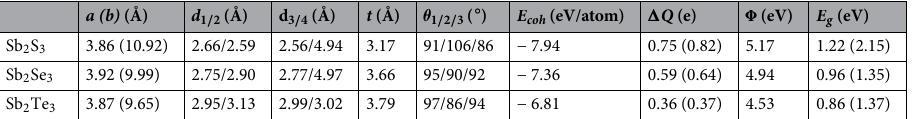
Table 1. Structural and electronic parameters of Sb 2 X 3 (X = S, Se, Te) monolayers as shown in Fig. 1b, including lattice constants a , b ; the bond lengths between Sb-X atoms d 1,2,3,4 ; the bond angles between X-Sb-X atoms θ 1,2,3 ; the thickness defined by the difference between the largest and smallest z coordinates of X atoms ( t ); the cohesive energy per atom, ( E coh ) ; the charge transfer (� Q ) between atoms Sb and X 1 ( X 2 ) atoms are shown inside (outside) parentheses as shown in Fig. 1b; the work function (�) . The band gap ( E g ) of PBE and HSE06 are shown outside and inside parentheses,